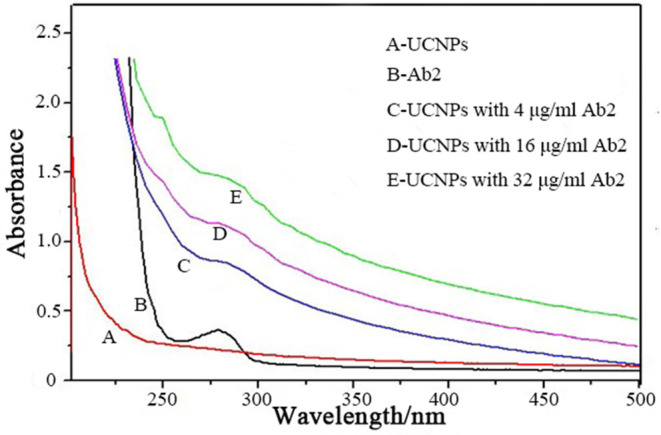
UV-vis spectroscopic characterizations of the conjugation of UCNPs@SiO2-NH2 and various concentrations of Ab2.